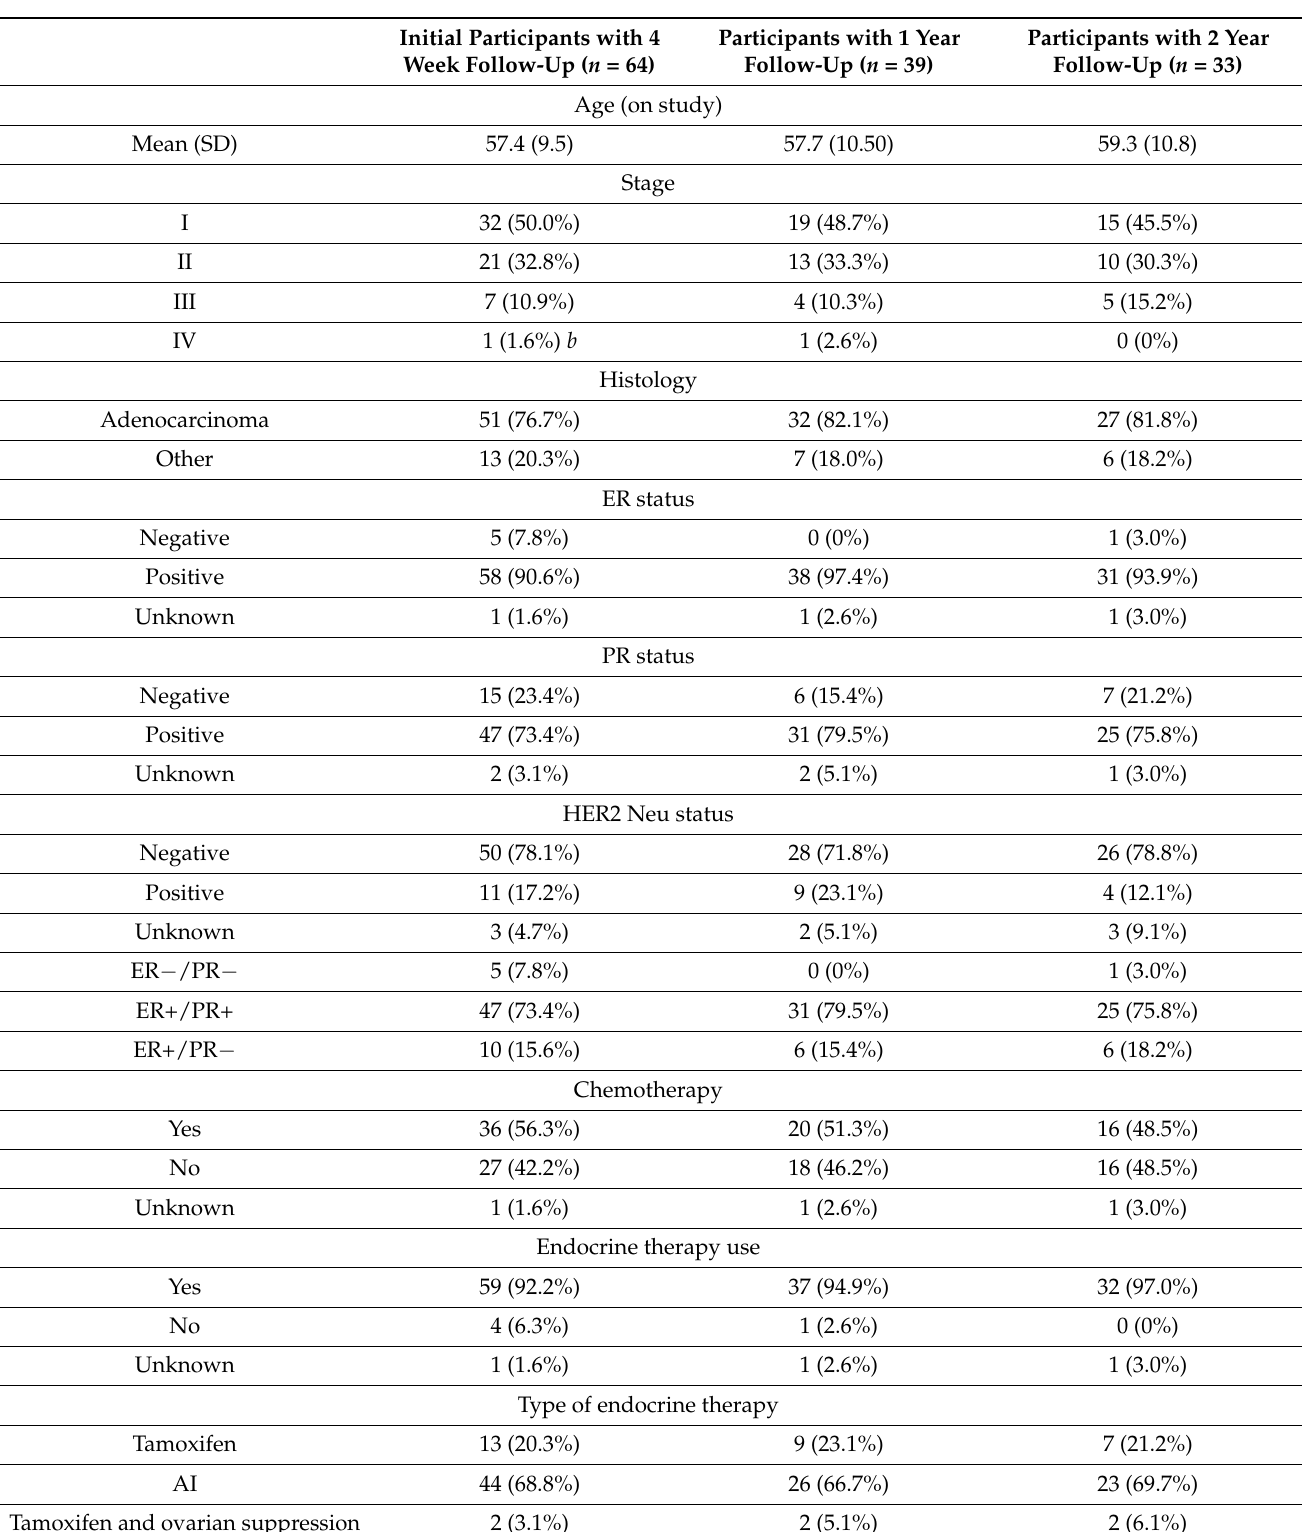
Table 1. Participant and breast cancer treatment